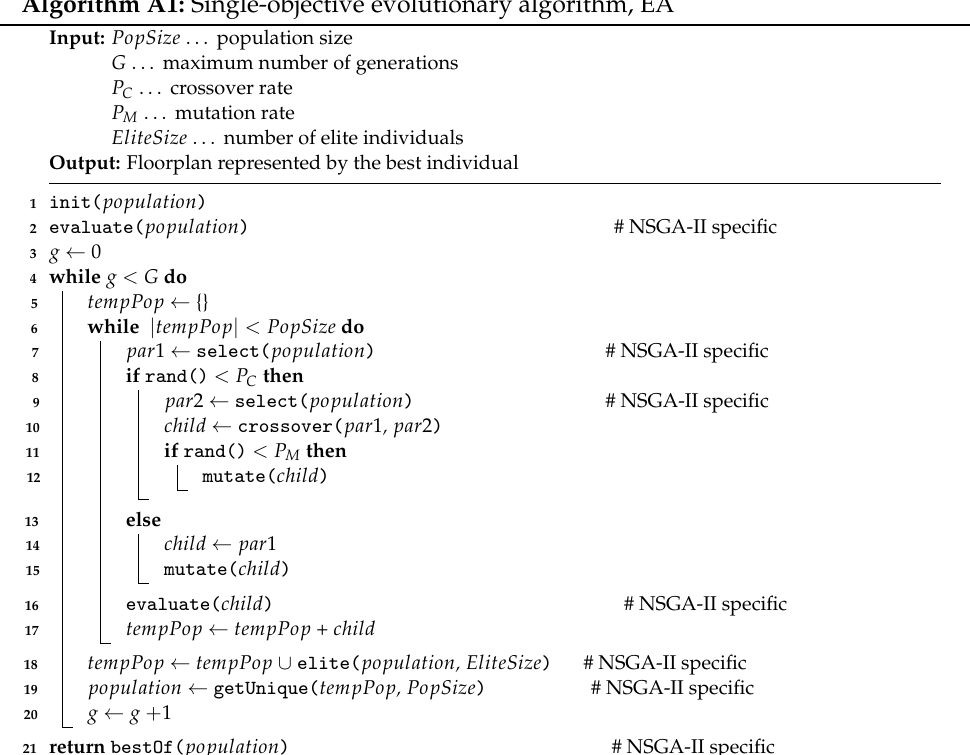
Algorithm A1: Single-objective evolutionary algorithm,